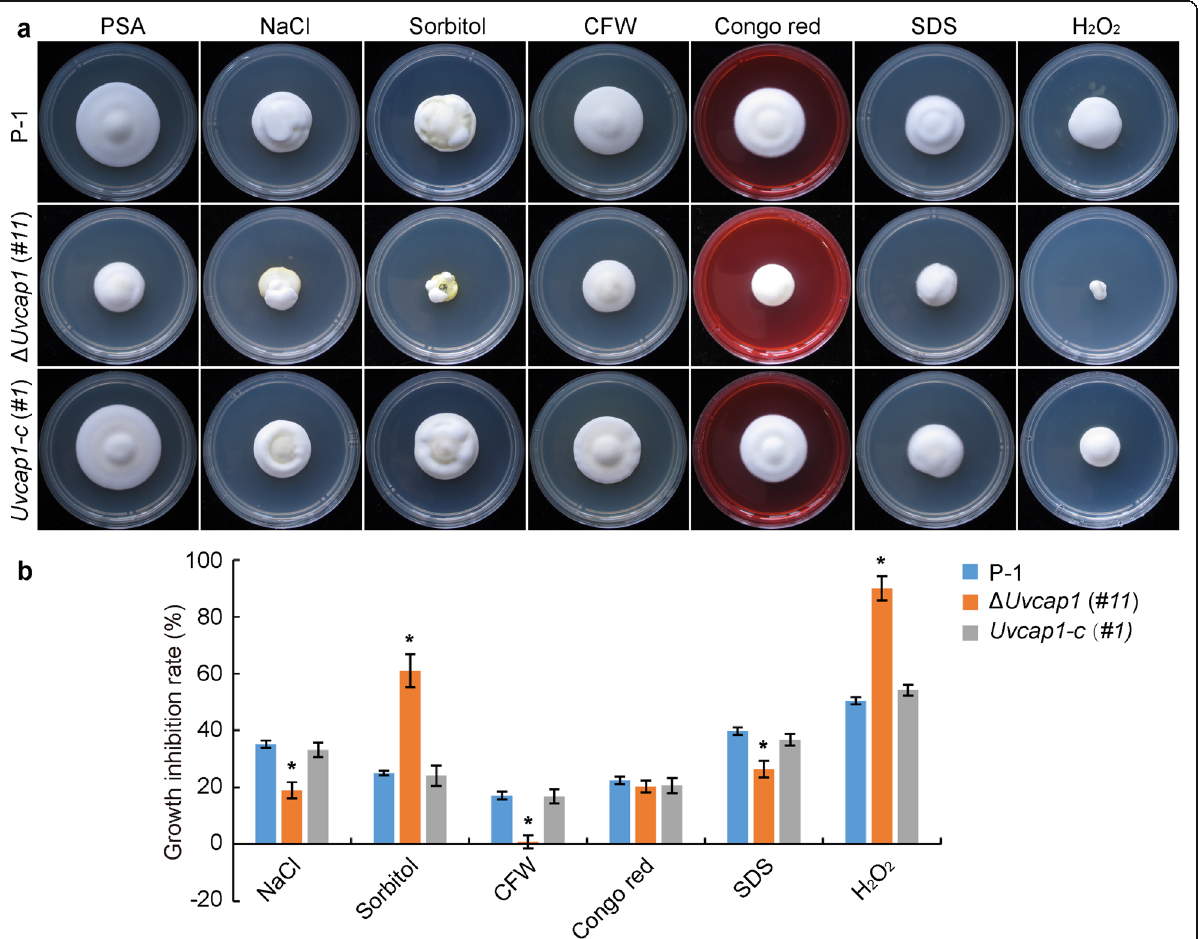
Fig. 4 UvCap1 regulates stress responses in U. virens . a Mycelial growth of the wild-type strain P-1, the Δ Uvcap1 ( #11 ) mutant and its complemented strain Uvcap1-c ( #1 ) on PSA plate or PSA with different concentrations of stress agents, including 0.5 M NaCl, 0.6 M sorbitol, 500 μ g/mL CFW, 100 μ g/mL Congo red, 0.05% SDS and 0.05% H 2 O 2 . b Column diagram showing the growth inhibition rate of strains cultured under different stress conditions in a. Error bars represent SD. * indicates significant differences between the mutant and the wild-type/or complemented strains as estimated by Duncan ’ s new multiple range test ( P <